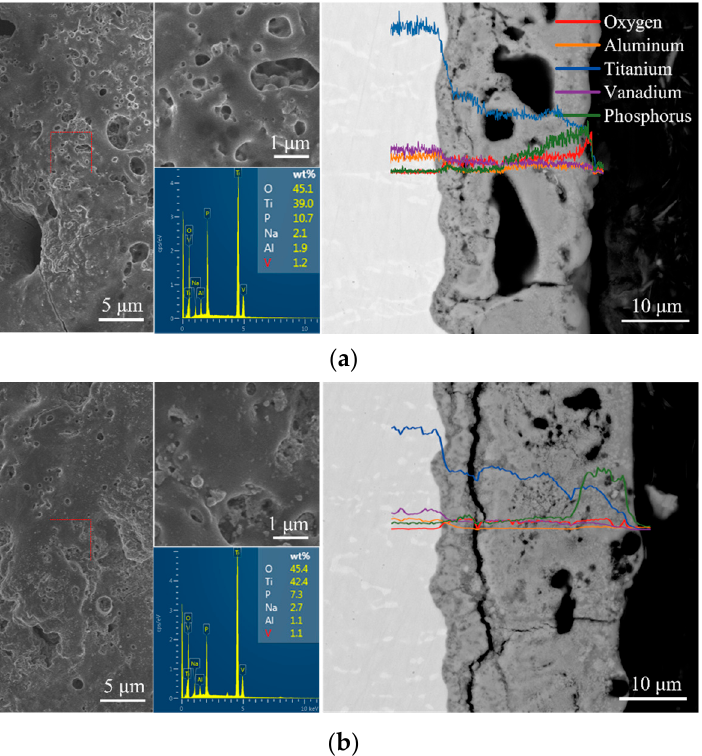
Figure 5. Surface morphology, cross-sectional morphology, and the corresponding EDS element distribution of the coating obtained by performing the MAO treatment in the Na 3 PO 4 electrolyte for ( a ) 600 and ( b ) 12,000 s.